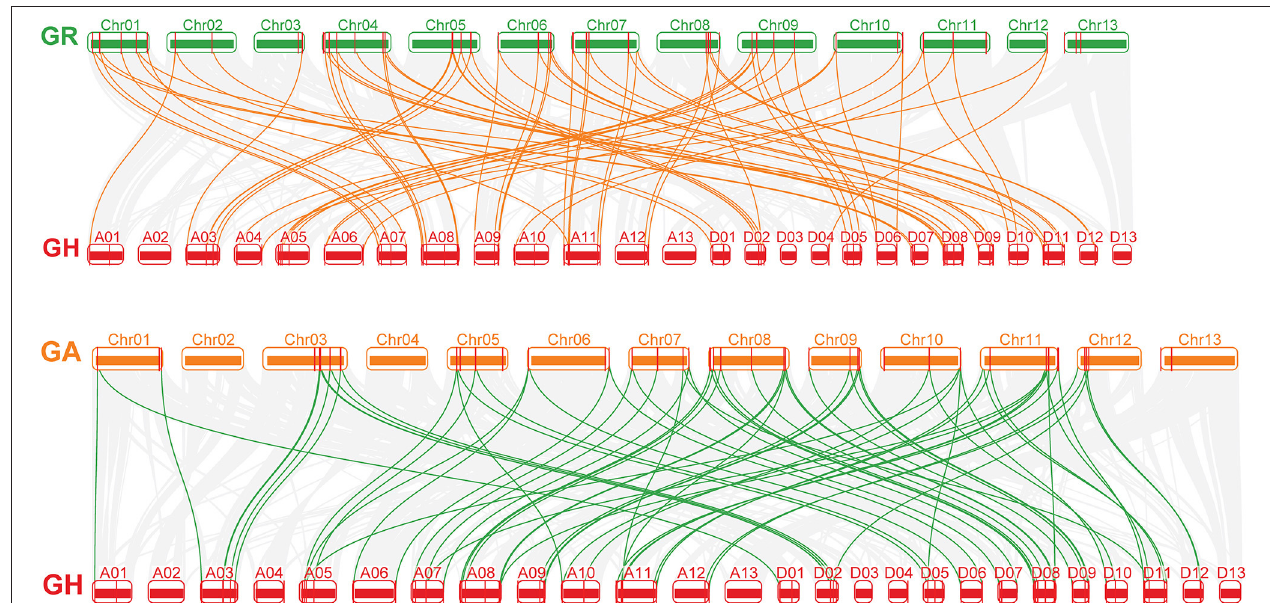
FIGURE 3 | The collinear relationship between G. arboreum and G. hirsutum and between G. raimondii and G. hirsutum (from bottom to top). The gray lines: the collinearity of the whole genome among cotton. The yellow and green lines: the collinearity of CLE pairs in